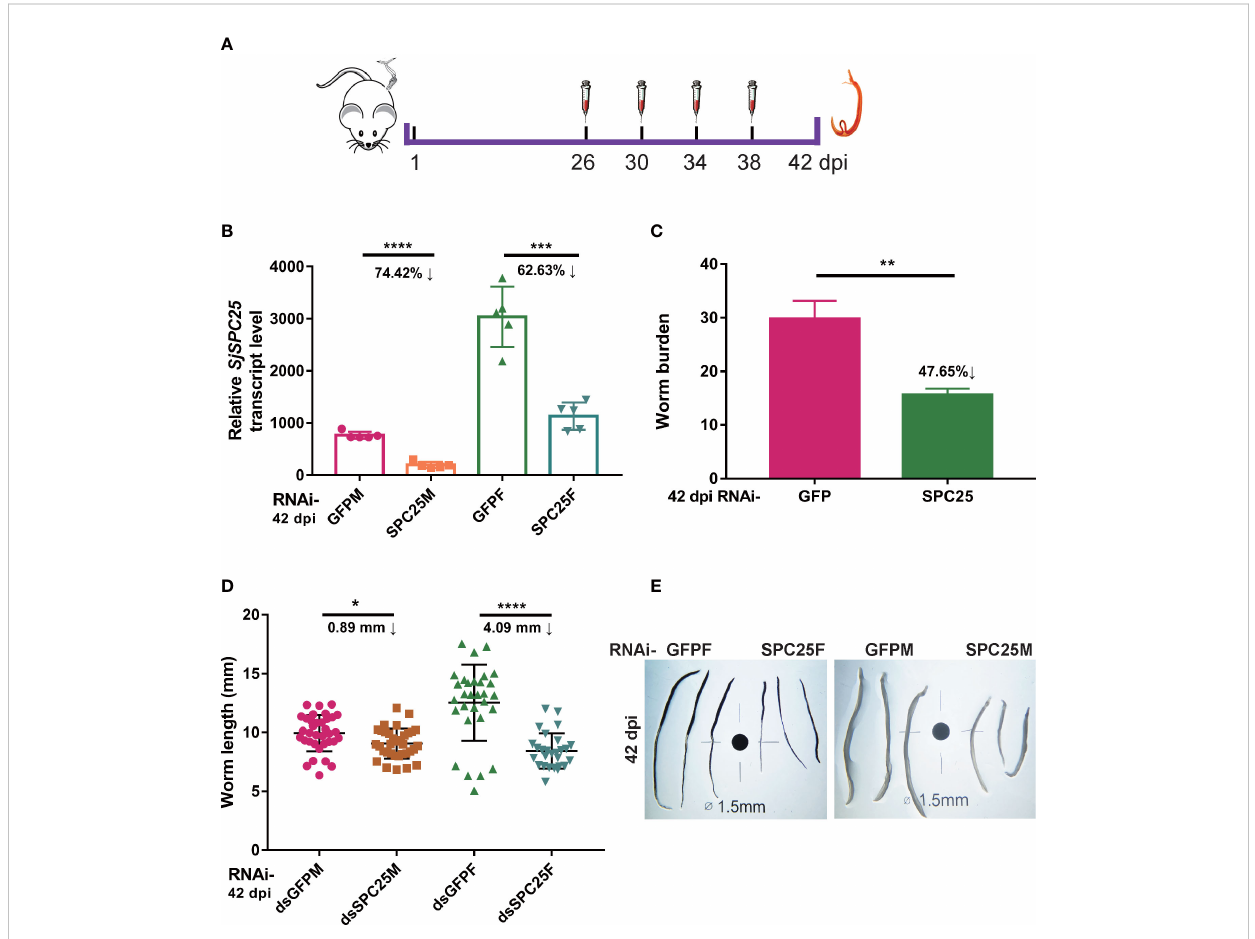
FIGURE 2 Effection on development and survival of adult S. japonicum. (A) Schematic diagram of the gene interference process of adult worms in vivo . (B) Ef fi cacy assessment of dsRNA-mediated SPC25 knockdown of worm collected at 42 dpi by qRT-PCR. (C) The number of worms collected at 42 dpi from the dsGFP- or dsSPC25-injected mouse. Each group had fi ve biological replicates. (D) Measurement of all worm lengths recovered from fi ve mice in each group at 42 dpi. The data were shown as means ± SEM. (E) Comparison of the length of worms collected at 42 dpi. * p < 0.05, ** p < 0.01, *** p < 0.001, **** p < 0.0001,